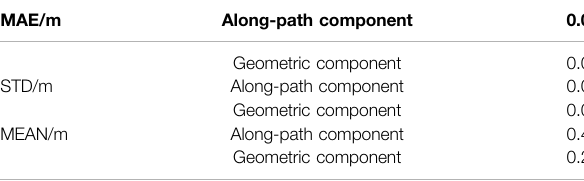
TABLE 1 | Results of airborne altimetry experimental data. MAE/m